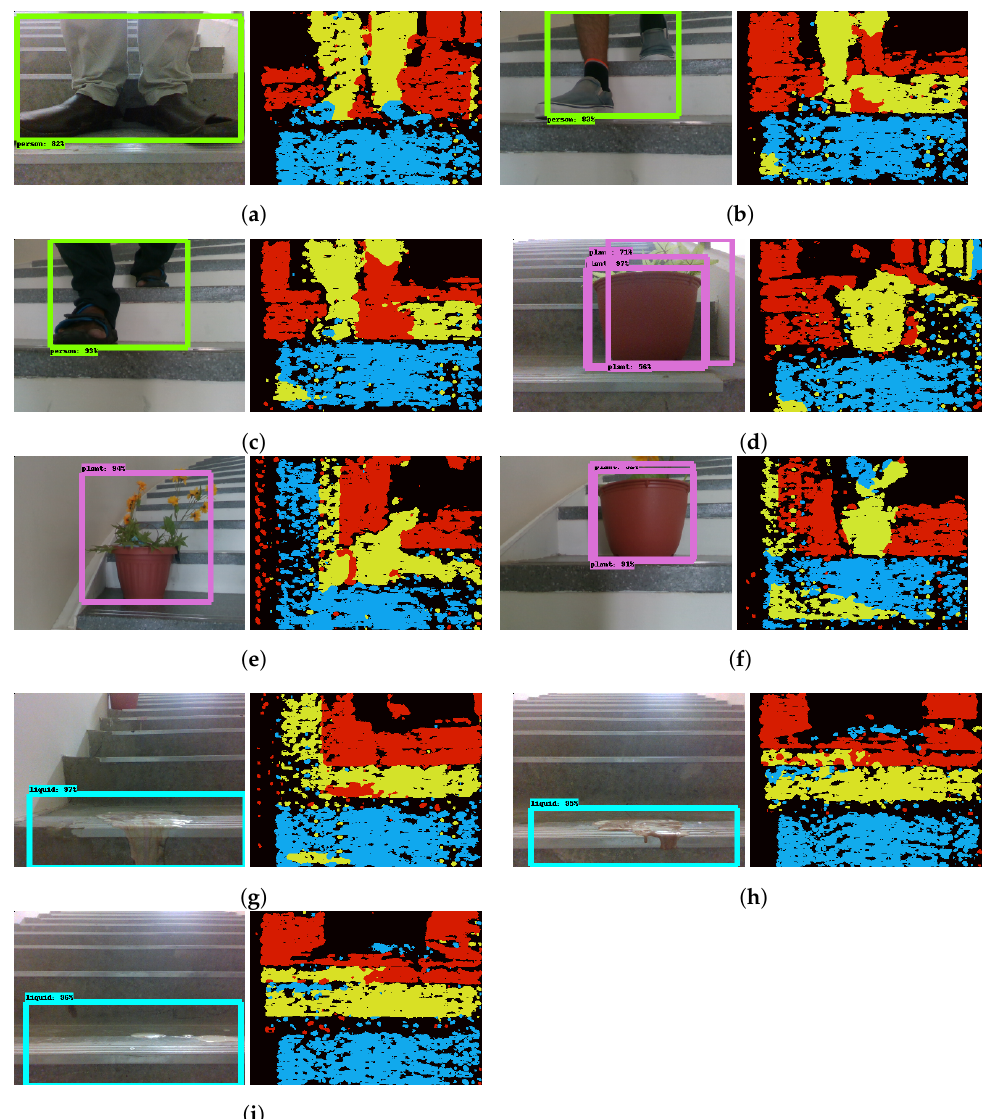
Figure 14. Detection and clustering results for obstacle and debris detection. Left: RGB detection, Right: Depth clustering. ( a – c ) Human detection; ( d – f ) Plant detection; ( g – i ) Debris detection.